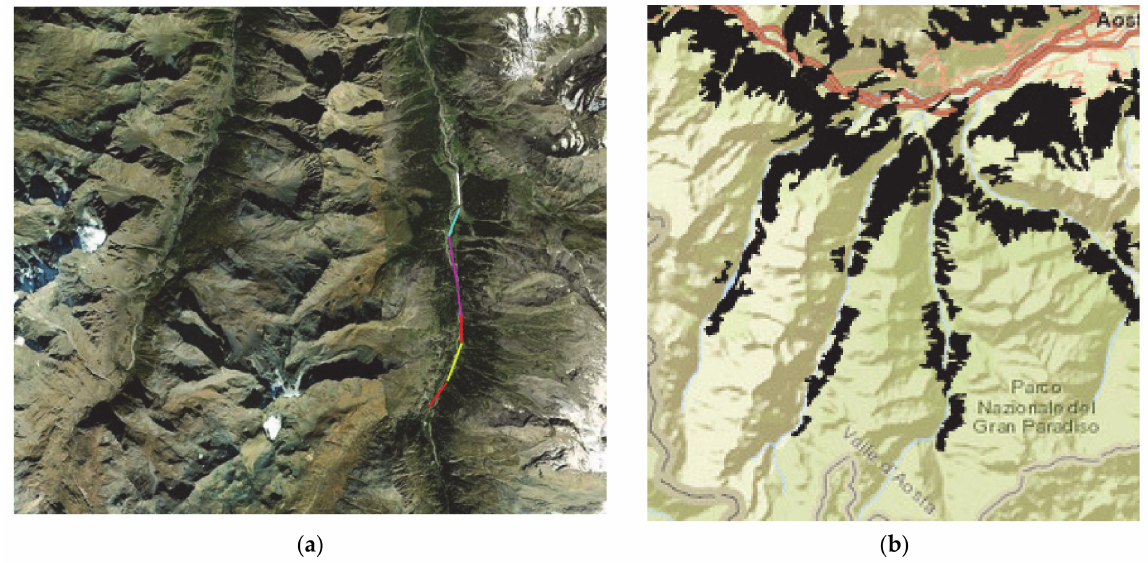
Figure 9. ( a ) Geolocalization of critical components due to tree falls; ( b ) geolocalization of areas characterised by tall trees based on CORINE information [25], case A3.